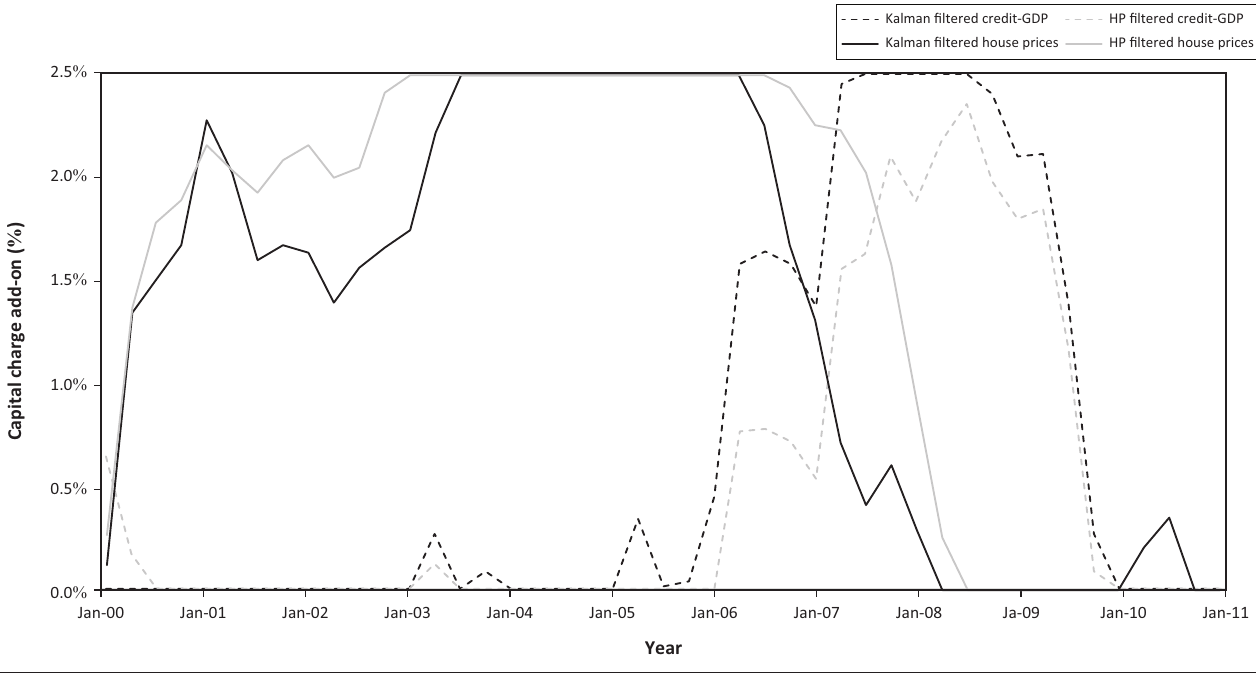
FIGURE 10: Countercyclical Capital Buffer capital charge add-on for credit-to-GDP and housing index series using the Kalman and HP filters pre- and during the credit crisis. HP,